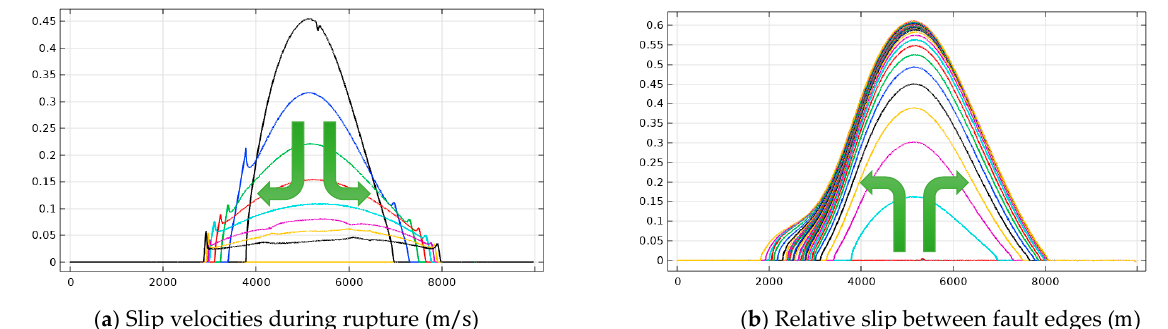
Figure 9. Time progress of the earthquake rupture: the patch grows in size during rupture. Abscissae represent the fault line ( m ), starting from its bottom. Green arrow pairs indicate the time evolution of the depicted quantities. ( a ) Velocities tangent to the fault plane ( m/s ). As seismic rupture goes on, the patch enlarges and the rupture velocity decreases. ( b ) The maximum relative slip between fault edges ( m ) induced during the earthquake rupture is 0.62 m .